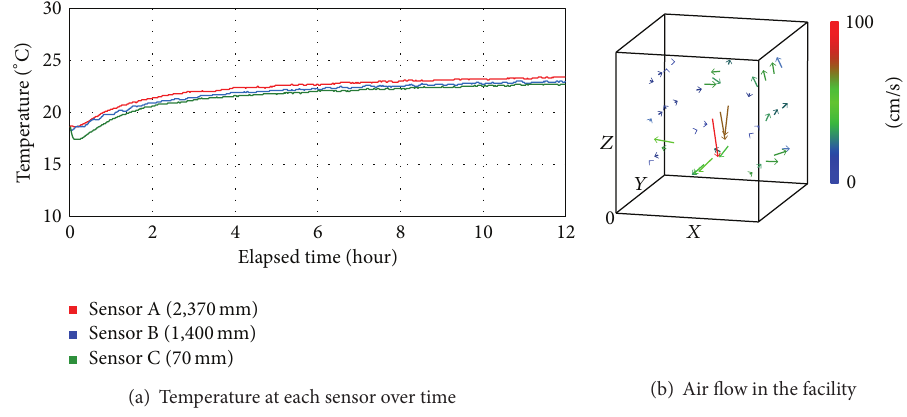
Figure 4: Temperature and air flow in the controlling condition of Case